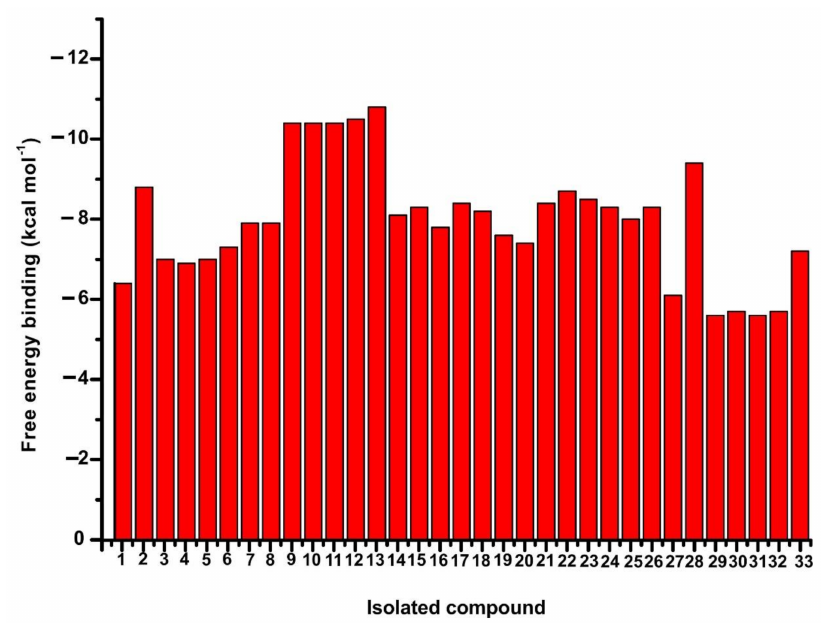
Figure 4. Illustration of the i nverse virtual screening calculated free energy binding of the 33 isolated compounds with